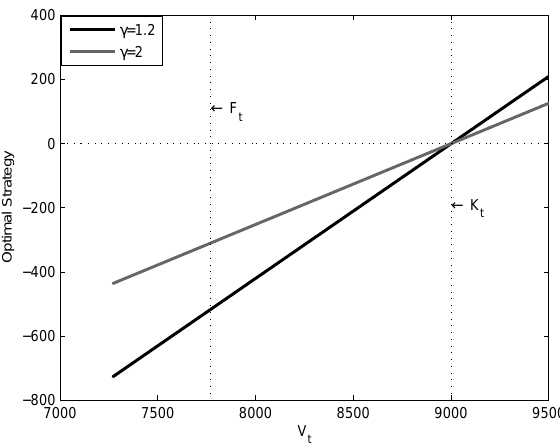
Figure 6. Optimal Strategy versus Value of the Pension Fund for different values of γ when ( σ =